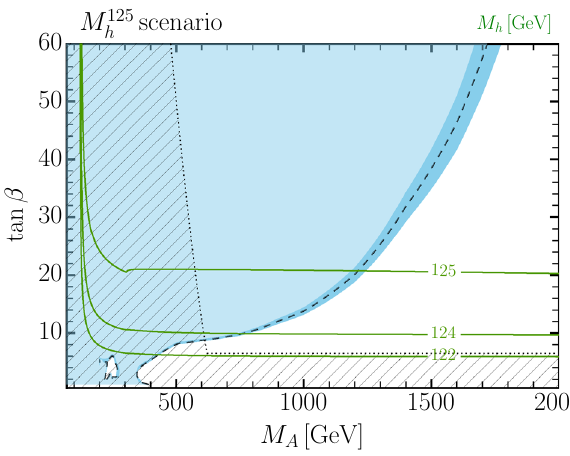
Fig. 1 Constraints on the M 125 scenario from Higgs searches at the h LHC, in the ( M A , tan β) plane. The green solid lines are predictions for the mass of the lighter CP -even scalar h , the hatched area is excluded by a mismatch between the properties of h and those of the observed Higgsboson,andtheblueareaisexcludedbythesearchesforadditional Higgs bosons (the darker-blue band shows the theoretical uncertainty of the exclusion)